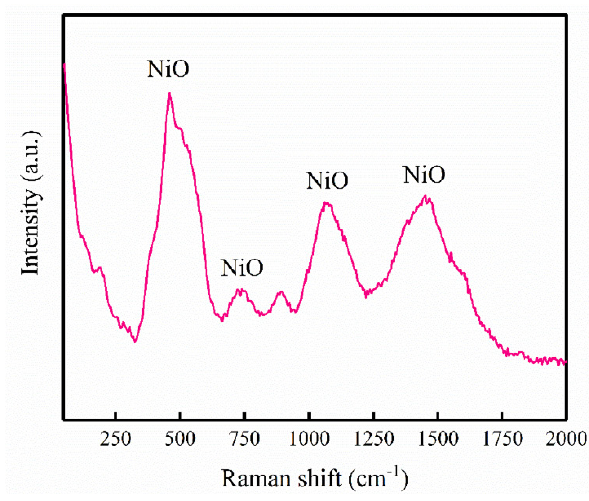
Fig. 6. The Raman spectrum of the electrode exposed to 400